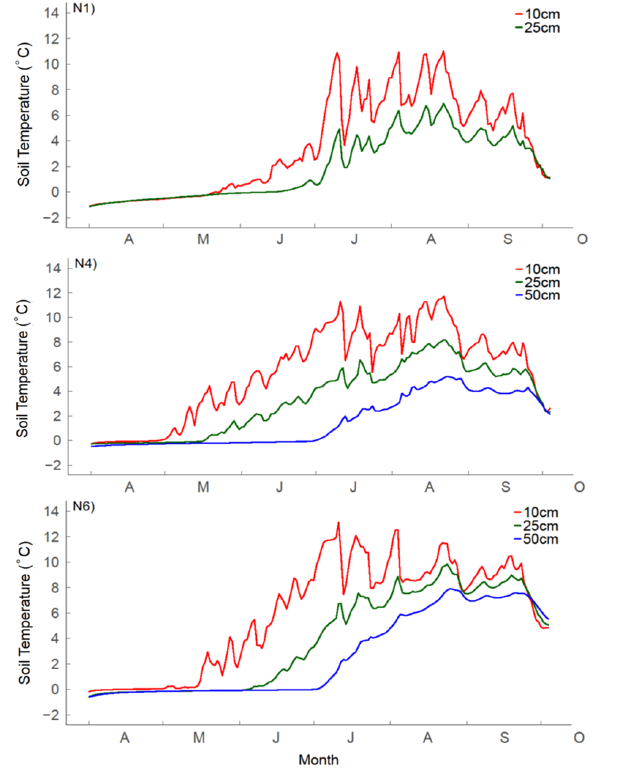
Figure 5. Seasonal changes in daily mean soil temperatures at N1, N4, and